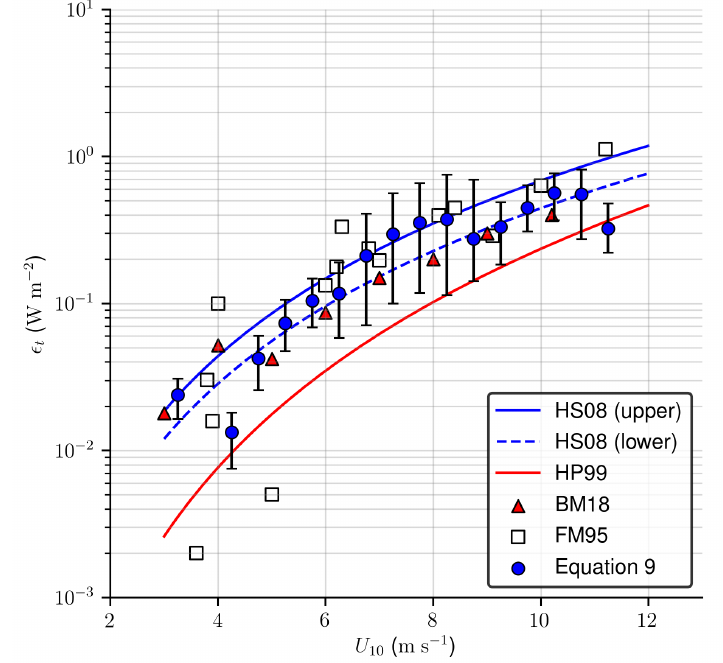
Figure 9. Relationship between total energy dissipation rate estimated from the SAR data versus U 10 , averaged in 0.5 m s − 1 wind speed bins. Blue circles with vertical bars are mean values and percentiles of 5% and 95%. Two parameterizations of (cid:101) t as a function of wind speed are shown, taken from [18] (HP99, red curve) and [26] (HS08, blue curves). Field estimation measurements taken from [17] (FM95, white squares) and [19] (BM18, red triangles) were also